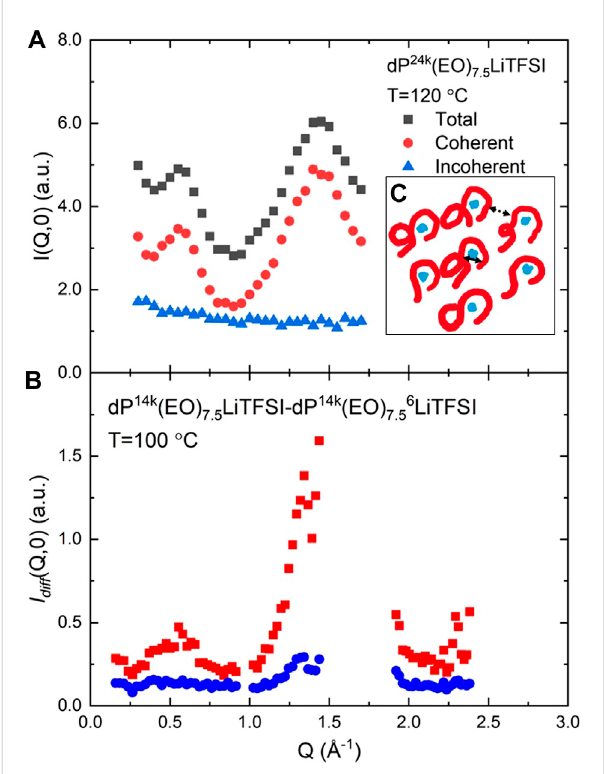
FIGURE 1 Structure factors and their coherent and incoherent fraction as determined using polarized diffraction. (A) sample 1a, measured at NCNR; (B) I diff (Q,0), obtained from sample 1b and sample 2 on WASP. The vertical scale is in arbitrary units and the intensity in the two plots should not be directly compared; as a reference for the reader, theincoherentintensityof I diff (Q,0) isabout10times smaller thanthat of sample 1b. Within (A) , the inset (C) is a sketch depicting the PEO chains(redlines)cylindrical arrangementaroundthelithiumions(blue dots) to form a 2D dense random packing. The double arrowed lines indicate the distance corresponding to the ERO (dotted) and IRO